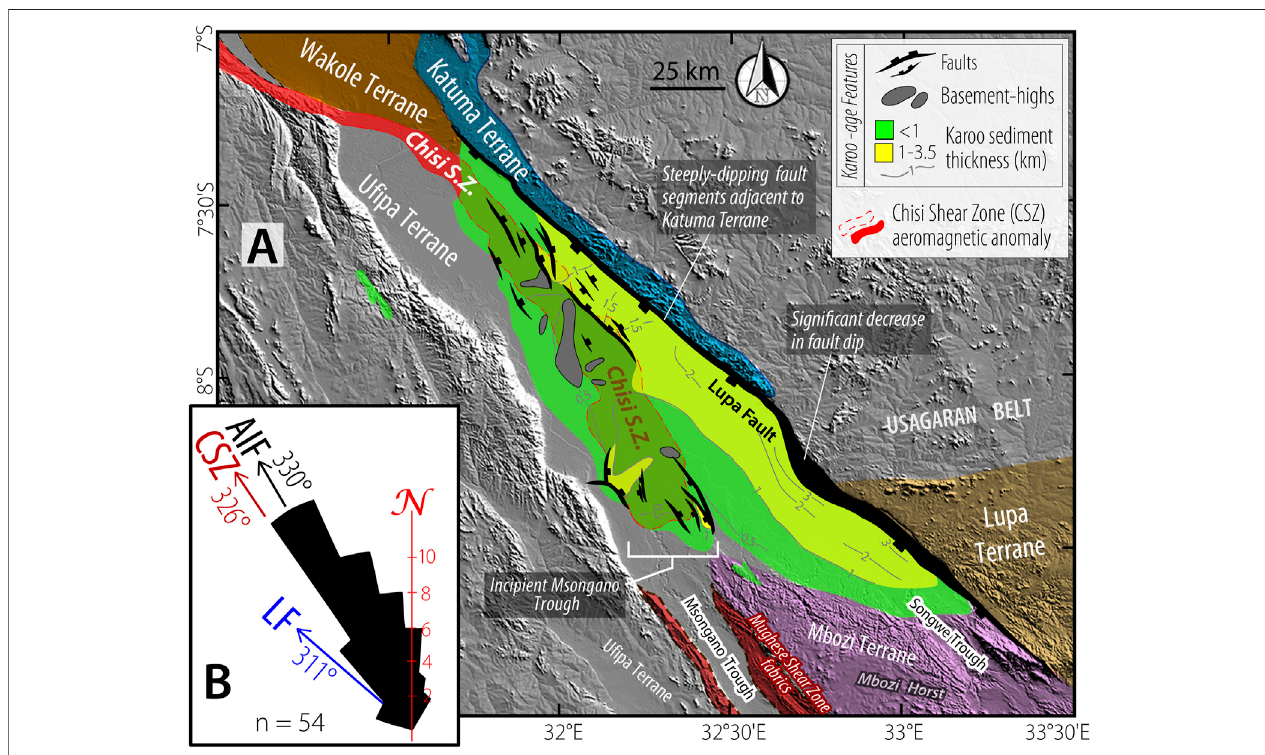
FIGURE 5 | (A) : Satellite DEM hillshade map of the Rukwa Rift, overlaid with the Karoo structural features (faults and basement ridges), Karoo isopach map (from Morley et al., 1992, 1999), Chisi Shear Zone magnetic anomaly, and the relevant surrounding basement terranes. (B) : Frequency-azimuth distribution of all the faults (Permian-Quaternary)intheRukwaRift(digitizedfromMorleyetal.,1992).ARF (cid:1) “ AllRukwaRiftfaults ” andblackarrowshowingtheirmeantrend;LF (cid:1) “ LupaFault ” and blue arrow showing its approximate trend; CSZ (cid:1) “ Chisi Shear Zone ” and brown arrow showing its approximate trend within the rift axis.